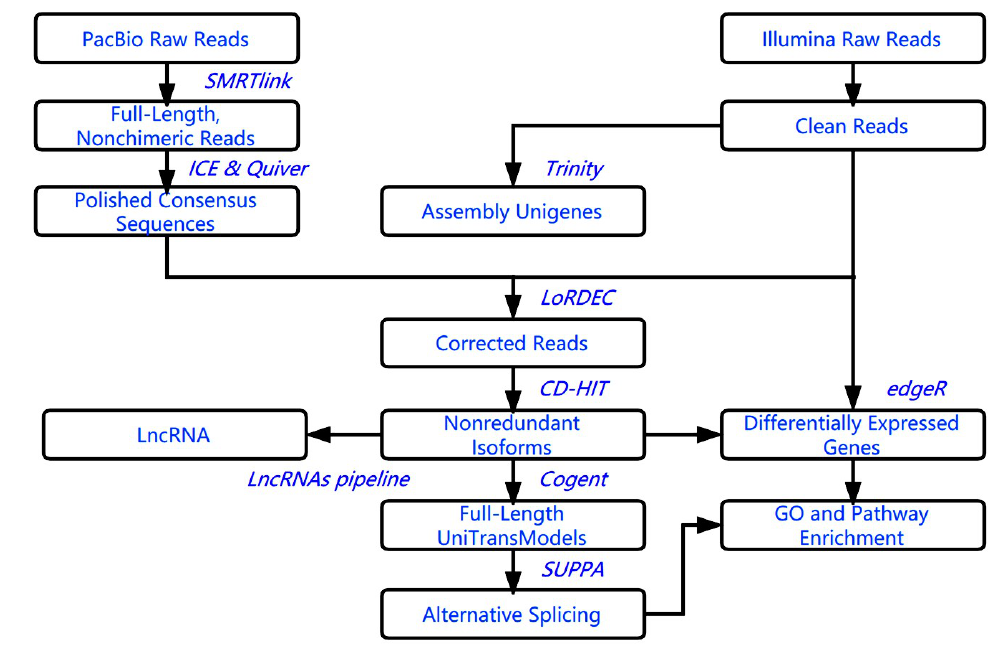
Figure 1. Pipeline used for analysis of hybrid sequencing data.